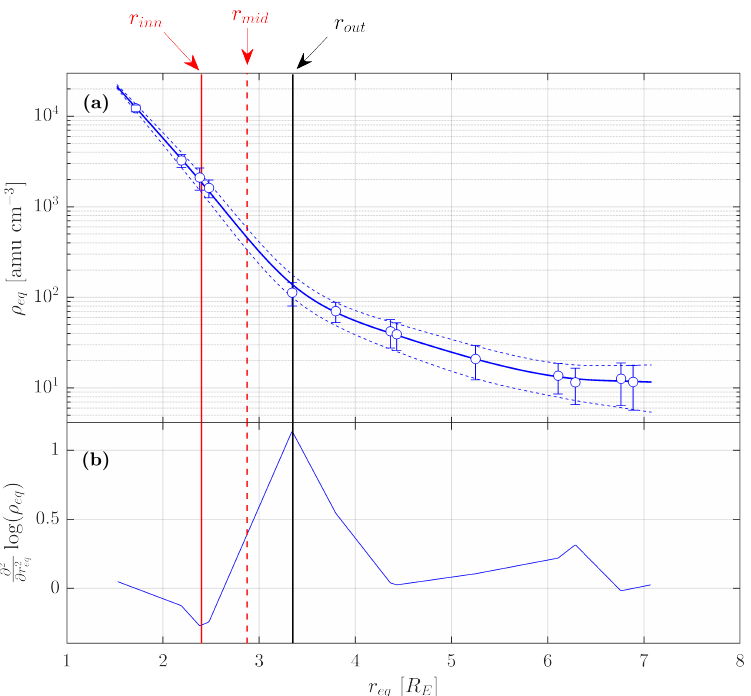
Figure 2. ( a ) Plasma mass density on day 153 at 07:00 UT; the open circles are the values obtained from the EMMA station pairs, and the vertical bars are their uncertainties; the solid lines are the fit, and the dashed lines are the uncertainty on the fit; ( b ) second derivative of log ( ρ ) ; the red and black solid lines are the position of the minimum ( r inn ) and the maximum ( r out ) of the second derivative of log ( ρ ) ; the red dashed line is the midpoint between r inn and r out .